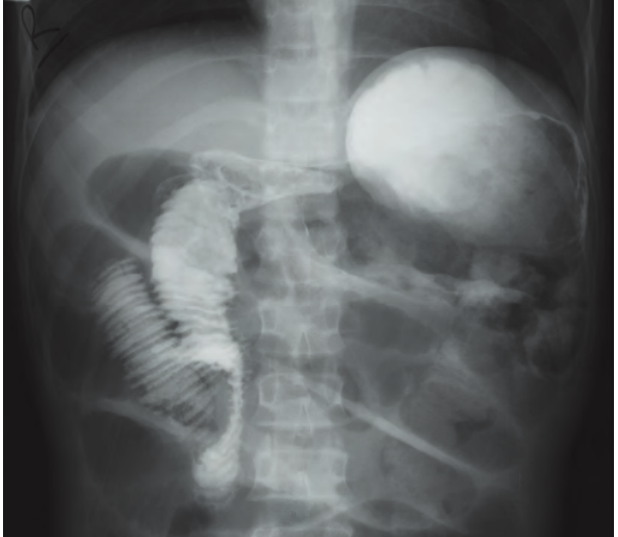
Fig. 2. Iodine contrast meal and follow-through demonstrates malrotation and volvulus of the proximal small bowel with dilation of the proximal duodenum with a ‘stacked coin’ mucosal pattern, possibly owing to ischaemia.